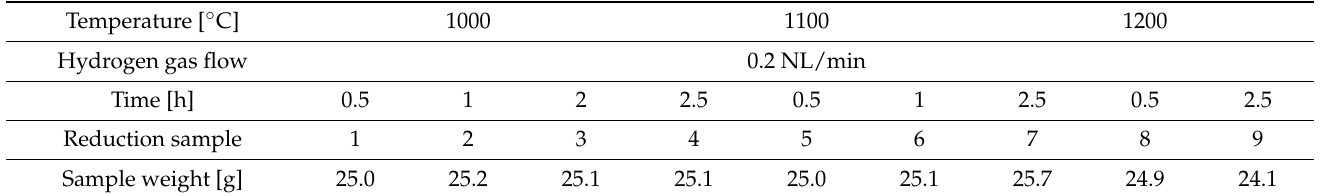
Table 3. Experimental conditions during hydrogen reduction and initial weight of each